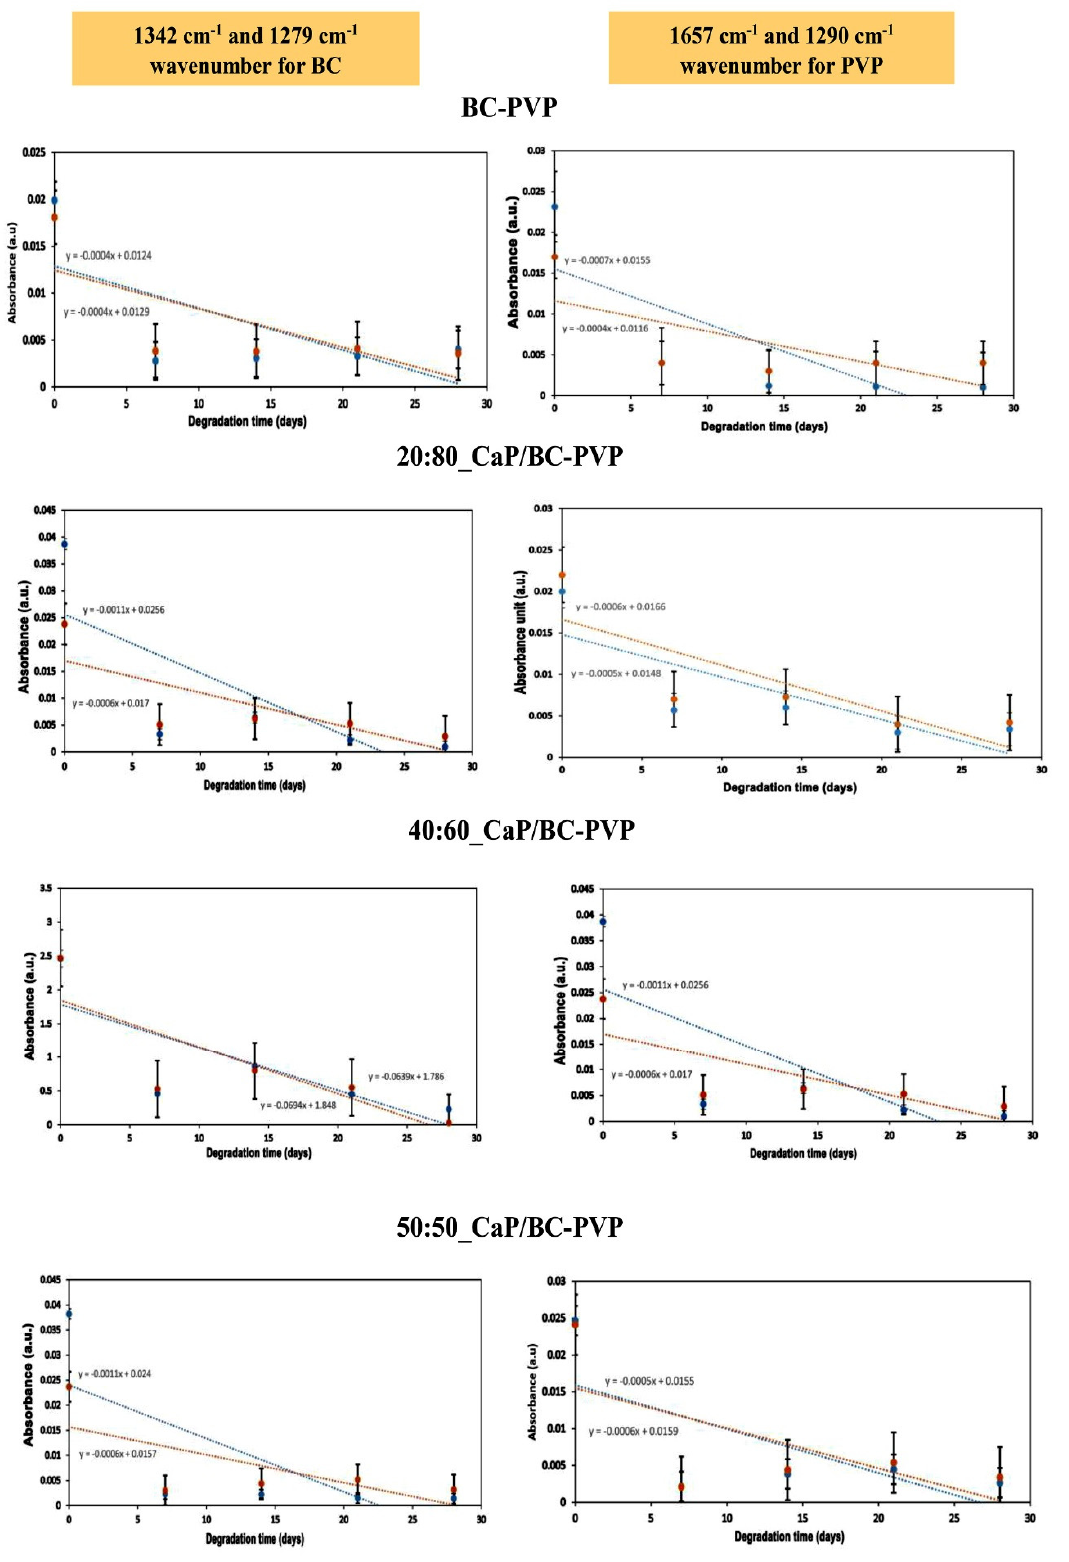
Figure 6. Relationship between the absorbance value of 1342, 1279, 1657, and 1290 cm − 1 wavenumbers and hydrolytic degradation time obtained by FTIR. Trend lines showing a decreasing trend (7, 14, 21, and 28 days).